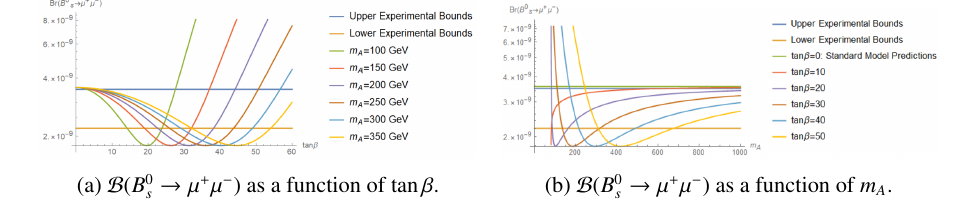
Figure 3: Dependence of the branching ratio on the parameters tan β and m A